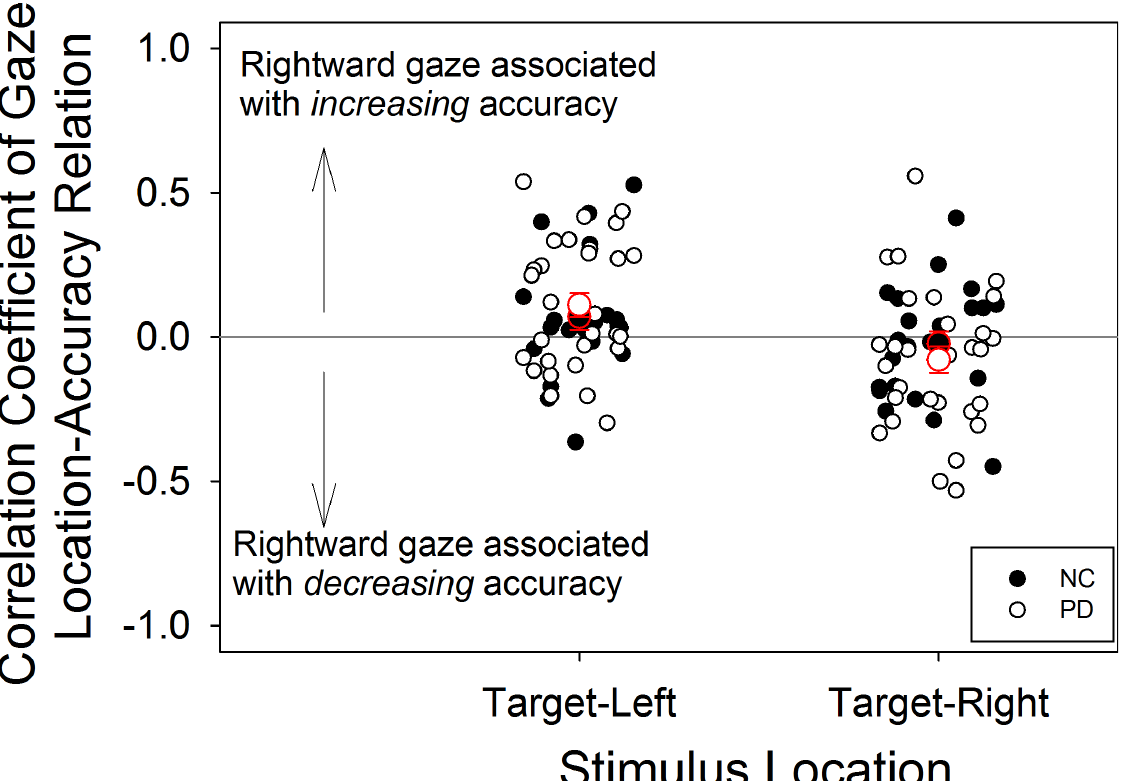
Fig 3. Relation between gaze location and accuracy for experiment 1. Group averages are shown with red outlines, and these indicate that the relation between gaze location and accuracy across subjects was weak, despite some medium strength correlations in individual